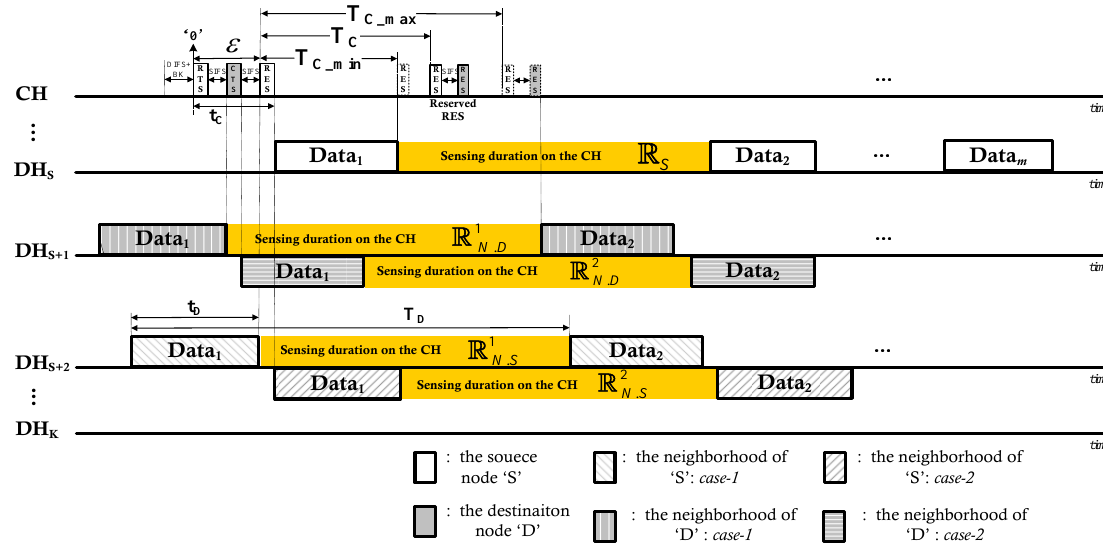
Fig. 2. The analysis of T C . Suppose the neighborhood of the destination node and the neighborhood of the source node transmit data packets over the data channel DH S +1 and DH S +2 , respectively. The missed control handshake information can be received by all of the neighbor nodes only if the transmission time of the two reserved RES packets within the intersection of R N.S , R N.D and R S . The detailed proof is presented in Section